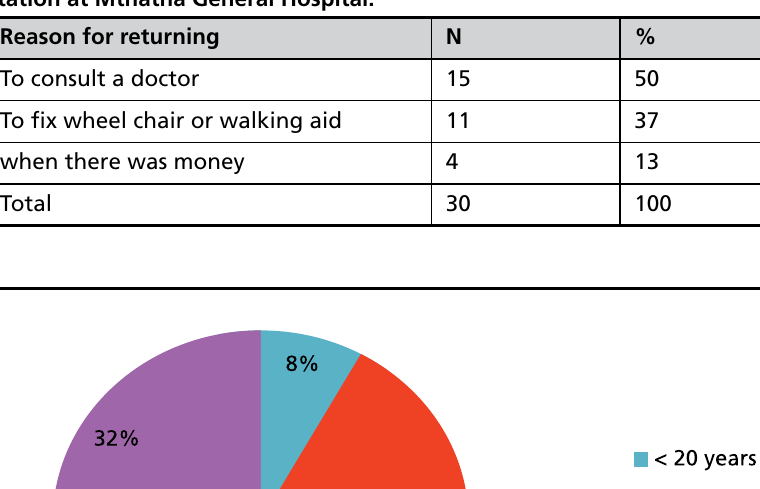
table 3. Reasons of patients (n=30) for returning to physiotherapy for rehabi-